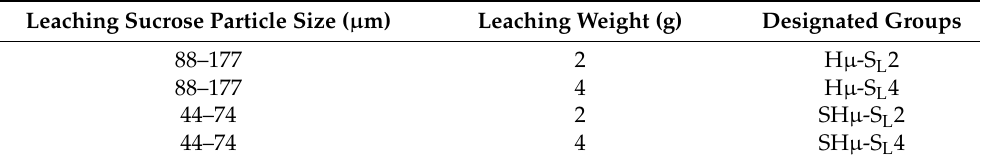
Table 1. Groups of specific hydrogel scaffolds were prepared by impregnating different particle sizes (88–177 and 44–74 µ m) and amounts (2 and 4 g) of porogen sucrose. Leaching Sucrose Particle Size ( µ